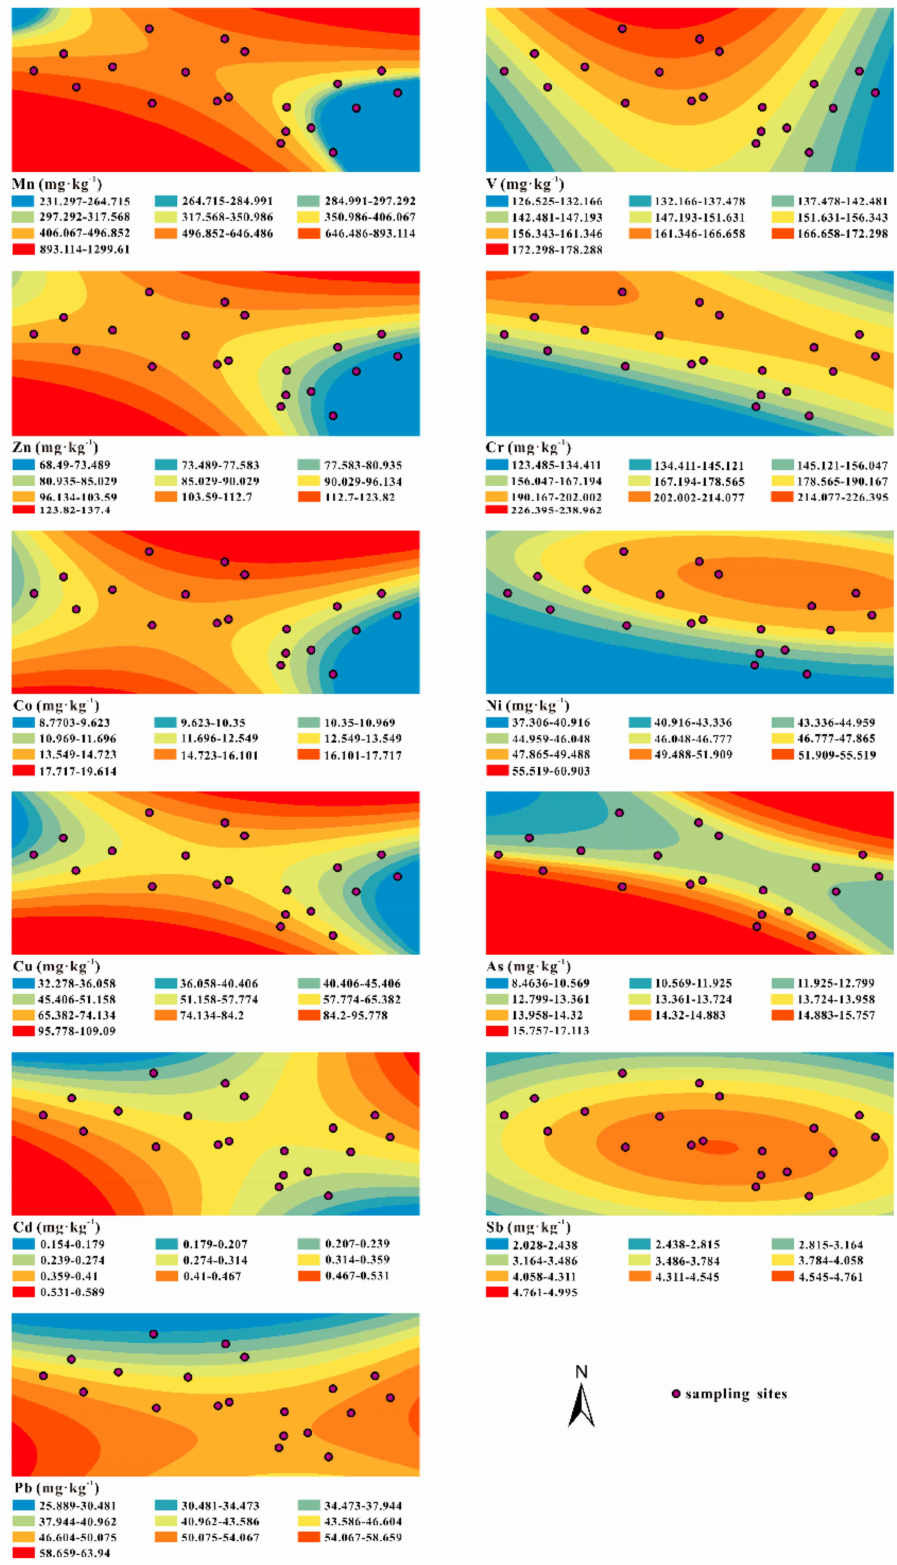
Figure 4. Spatial distributions of 11 PHTEs in 20 surface soil samples from Jiulongchi wetland of Fanjing Mountain, southwest